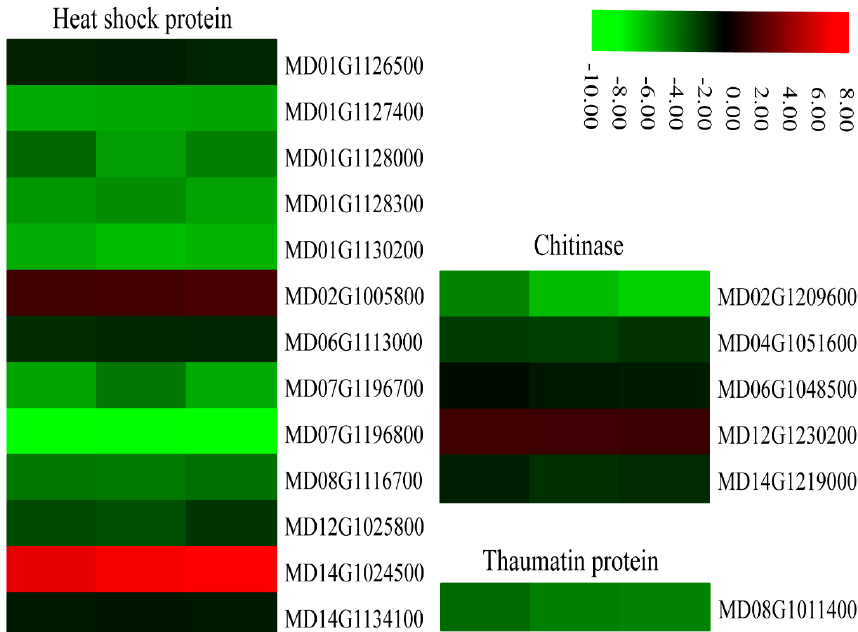
Figure 10. Heatmaps of DEGs encoding defense ‐ related proteins. The log2|Foldchange| was colored using TBtools (red indicates the DEG was up ‐ regulated in the MdMLP423 ‐ overexpressing calli compared with the CK calli, green indicates it was down ‐ regulated). Each row represents three independent comparisons (T_1/CK_1, T_2/CK_2, and T_3/CK_3) from left to right.